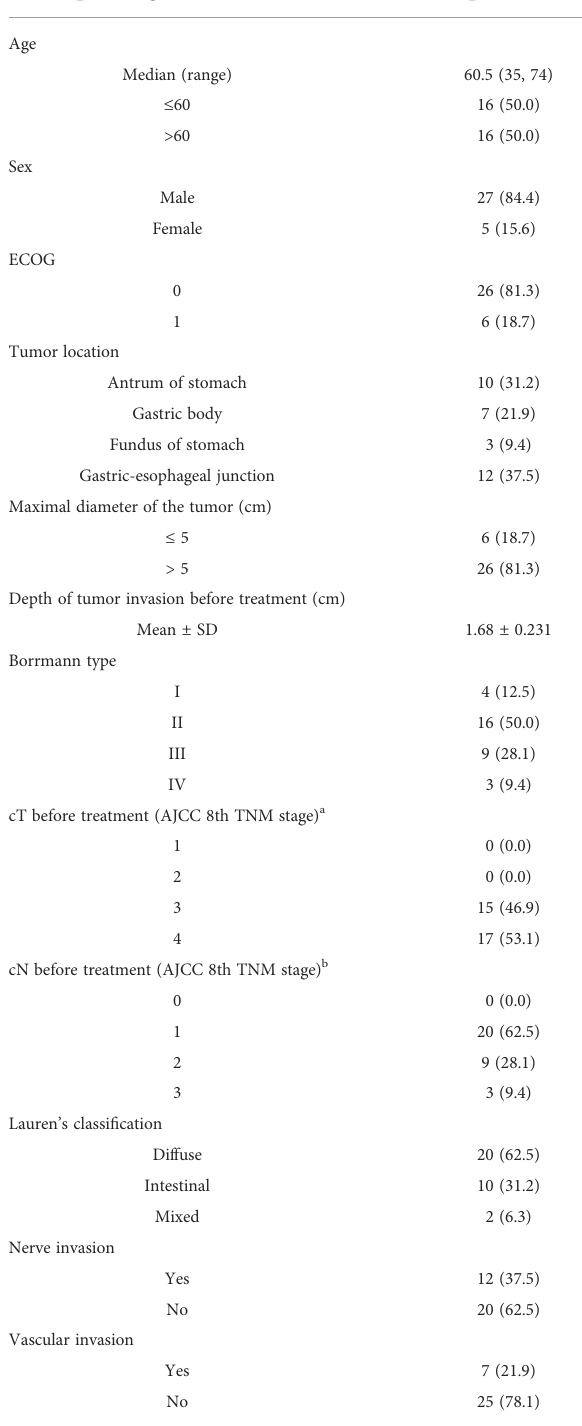
TABLE 1 Baseline clinicopathological characteristics of patients with gastric cancer. Clinicopathological